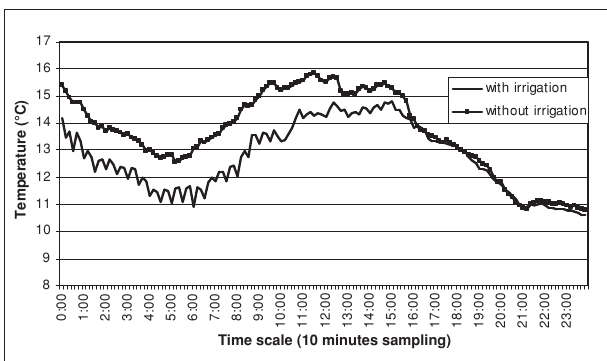
Figure 2: Effect of irrigation those days when the night temperature (T>10 °C) and wind speed (Vaverage >10 m/s) was high between March 15 and